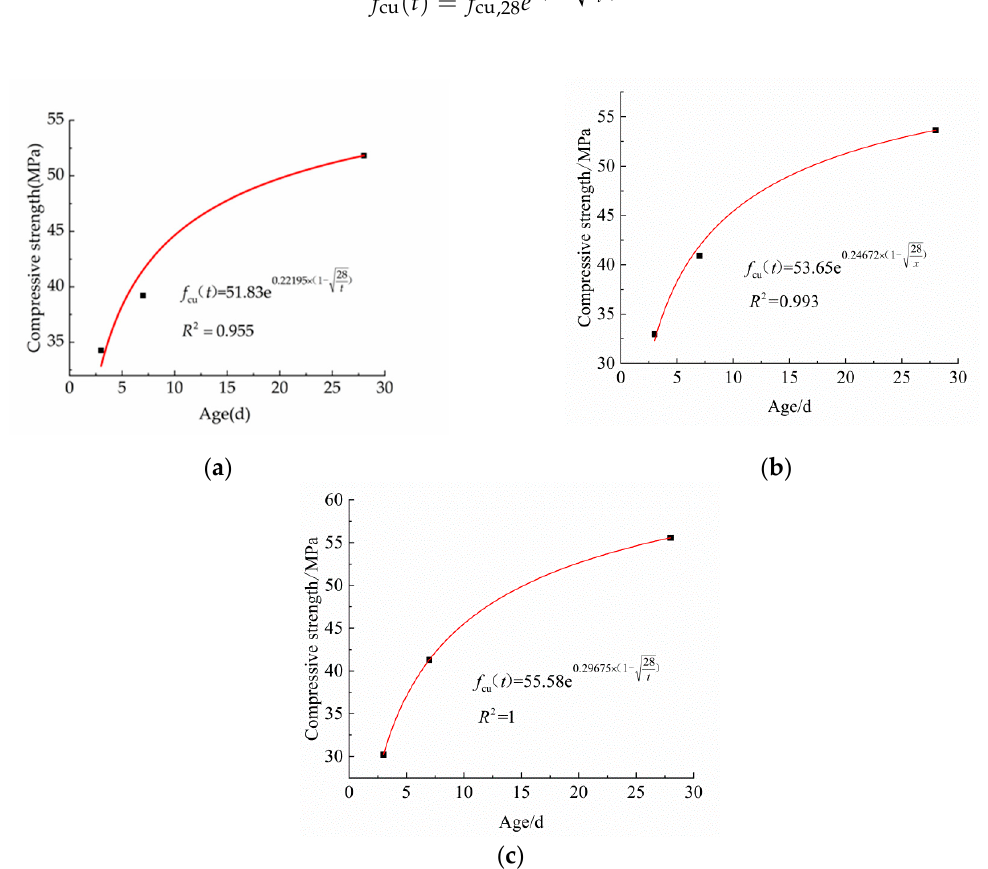
Figure 6. These are the modified formulas of the compressive strength of SCC with the low fly ash and silica fume content. ( a ) Fitting formula with a fly ash replacement rate of 10%; ( b ) Fitting formula with a fly ash replacement rate of 20%; and ( c ) Fitting formula with a fly ash replacement rate of 30%.